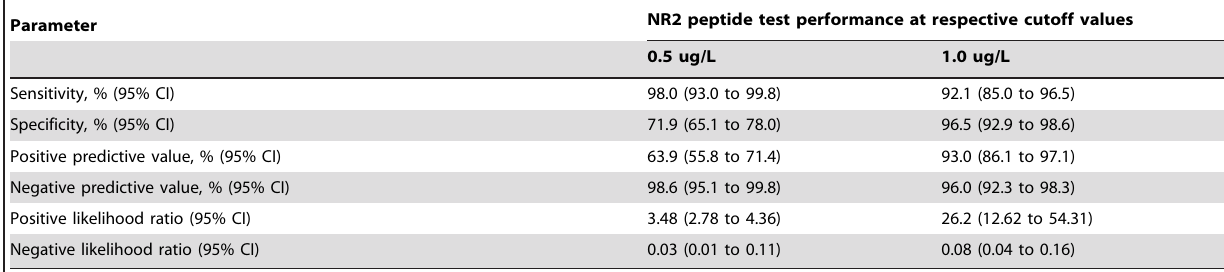
Table 2. Operating characteristics of different cutoff points for NR2 peptide concentrations in all study